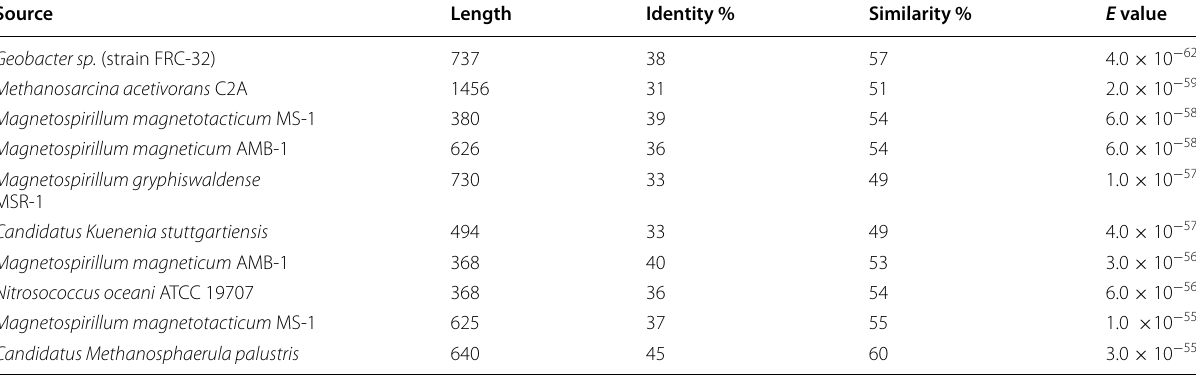
Table 3 Amino acid lengths, percent identities, and similarities of the proteins with highest homology to RegO and their respective E values, as obtained from the BLAST search Source